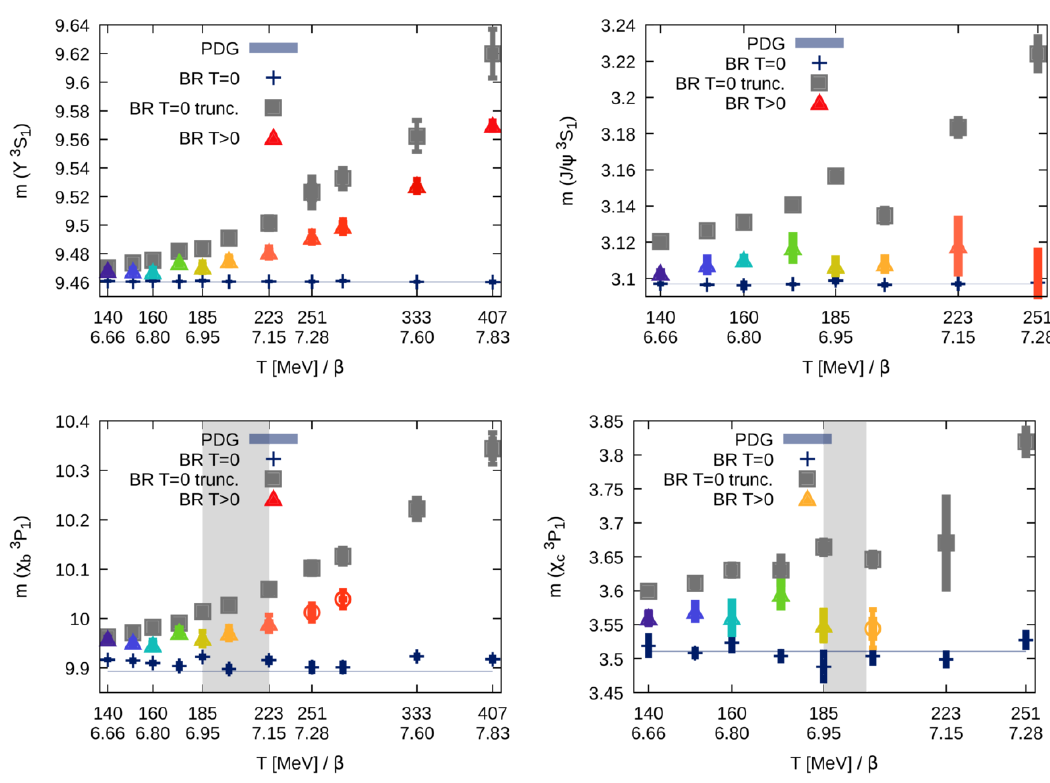
Figure 23 . The in-medium masses of quarkonium in lattice NRQCD together with the appropriate baseline from a truncated T = 0 reconstruction. All data points are obtained with the standard BR method with bottomonium results on the left and charmonium on the right. We present the S-wave channels in the top row and the P-wave channels in the bottom row. Three sets of points are contained in each panel: dark blue crosses denote the reconstructed peak position at zero temperature, arising from lattices with the same lattice spacing used in the corresponding (cid:12)nite temperature mass estimate given as colored triangles. The x-axis therefore carries both labels for temperature in MeV and the lattice (cid:12) parameter. The PDG ground state mass is given as blue solid line. The gray (cid:12)lled squares on the other hand denote the masses extracted from the truncated T = 0 input data sets and represent the correct baseline to which the in-medium masses need to be compared to. The area to the right of the gray separator refers to the temperature range in which the smooth BR method indicates that the standard BR method may not provide a robust determination of the ground state